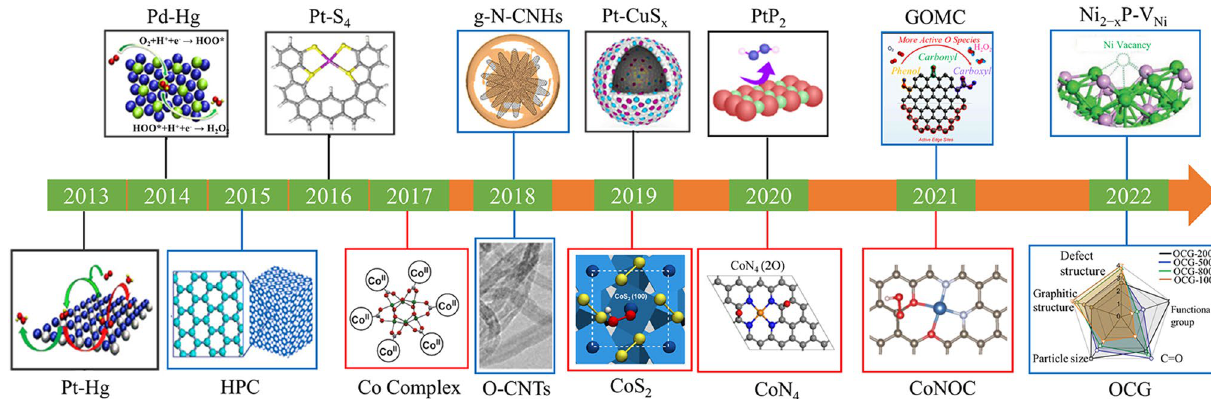
Fig. 2 Timeline of some significant findings of 2e – ORR electrocatalyst. PtHg 4 : Reproduced with permission [11]. Copyright 2013, Springer Nature. Pd 2 Hg 5 : Reproduced with permission [61]. Copyright 2014, American Chemical Society. HPC: Reproduced with permission [131]. Copyright 2015, Wiley VCH. Pt-S 4 : Reproduced with permission [79]. Copyright 2016, Springer Nature. Co Complex: Reproduced with per- mission [93]. Copyright 2017, American Chemical Society. g-N-CNHs and O-CNTs: Reproduced with permission [138, 146]. Copyright 2018, Elsevier Inc. and Copyright 2018, Springer Nature. Pt-CuS x and CoS 2 : Reproduced with permission [77, 98]. Copyright 2019, Elsevier Inc. and Copyright 2019, American Chemical Society. PtP 2 and CoN 4 : Reproduced with permission [64, 120]. Copyright 2020, Springer Nature. CoNOC and GOMC: Reproduced with permission [121, 132]. Copyright 2021, Springer Nature and Copyright 2021, Elsevier Inc. Ni 2-x P-V Ni and OCG: Reproduced with permission [100, 134]. Copyright 2022, Wiley VCH. and Copyright 2022, Royal Society of Chemistry. Black: noble metal- based catalysts. Blue: carbon-based catalysts. Red: transition metal-based catalysts. (Color figure online)